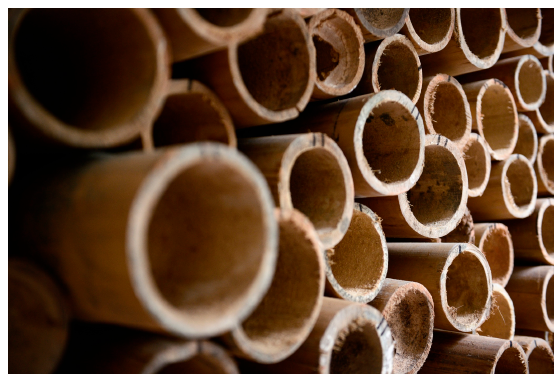
Figure 1. Bamboo Dendrocalamus asper used in this study to fabricate the bamboo composite materials.